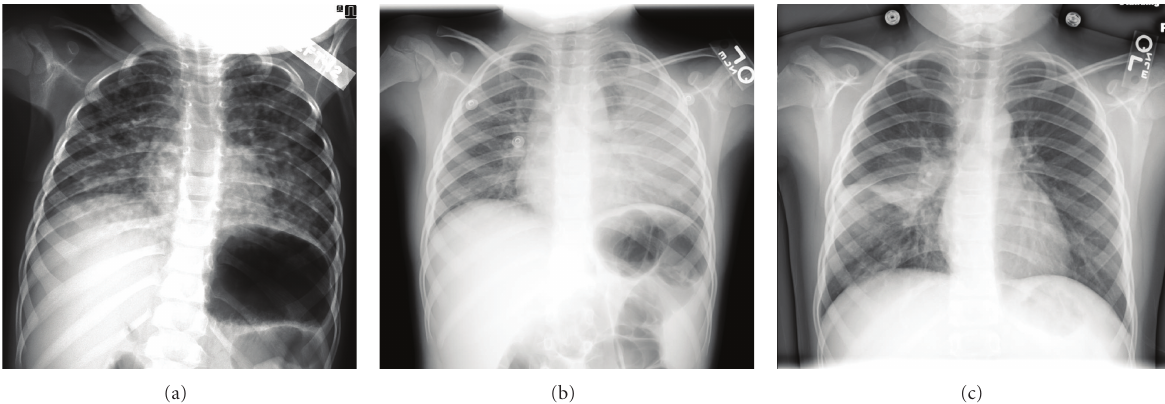
Figure 2: Chest radiographs prior to admission. Images demonstrating focal opacities with variable patterns, from extensive di ff use nodularity (a) to large opacifications involving several areas of the lungs ((b) and (c)). These films were taken at 3 years (a), 6 years (b), and 8 years (c) of age during prior episodes of